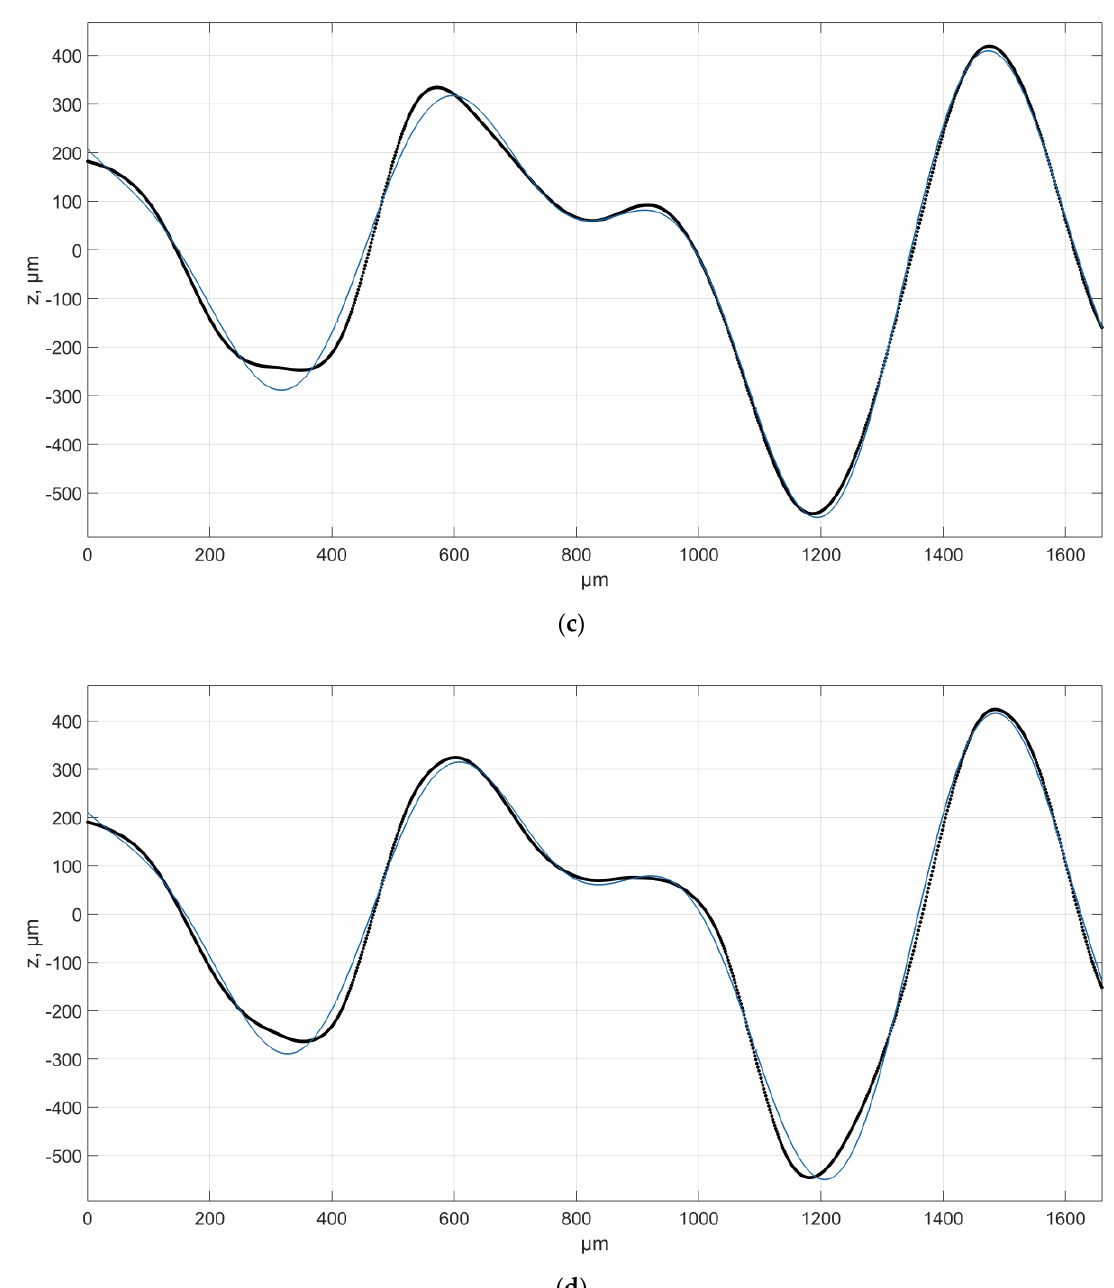
Figure 7. Example of a surface profile together with a sixth analysis level approximation function: ( a ) sample No. 1 coif5 wavelet, ( b ) sample no. 1 sym8 wavelet, ( c ) sample no. 4 coif5 wavelet, ( d ) sample no. 4 sym8 wavelet. The black color indicates the profile obtained by wavelet analysis, the blue color indicates approximation